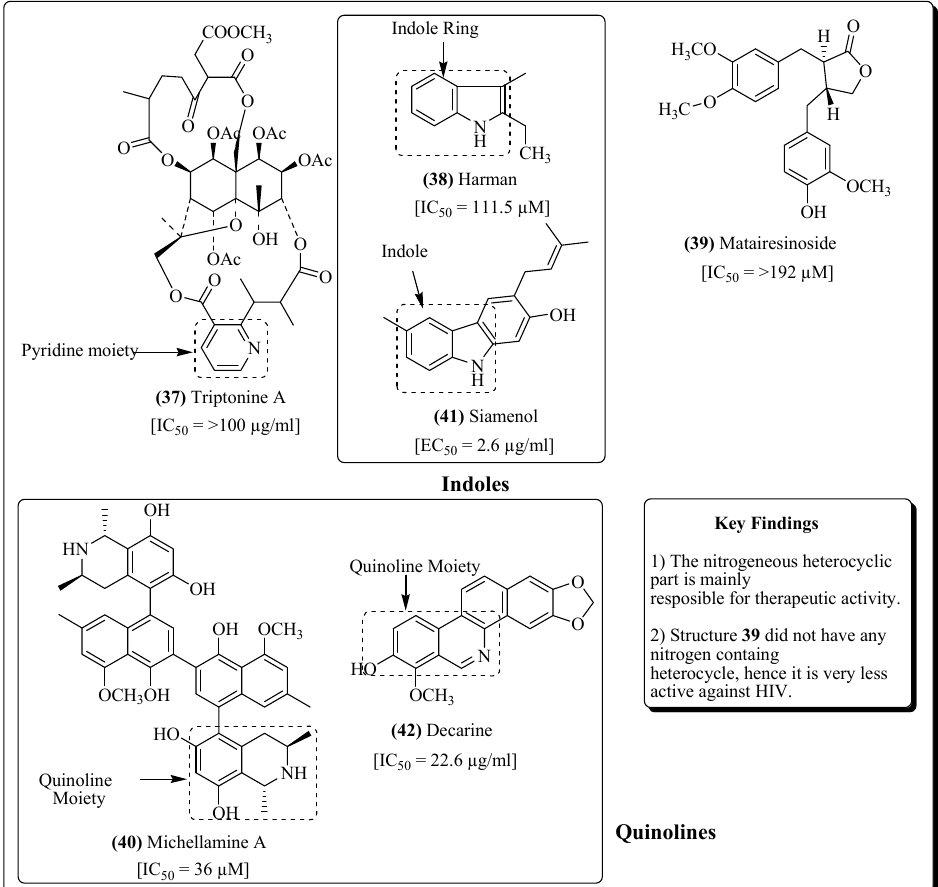
Figure 10. Alkaloidal compounds possessing anti-HIV activity.